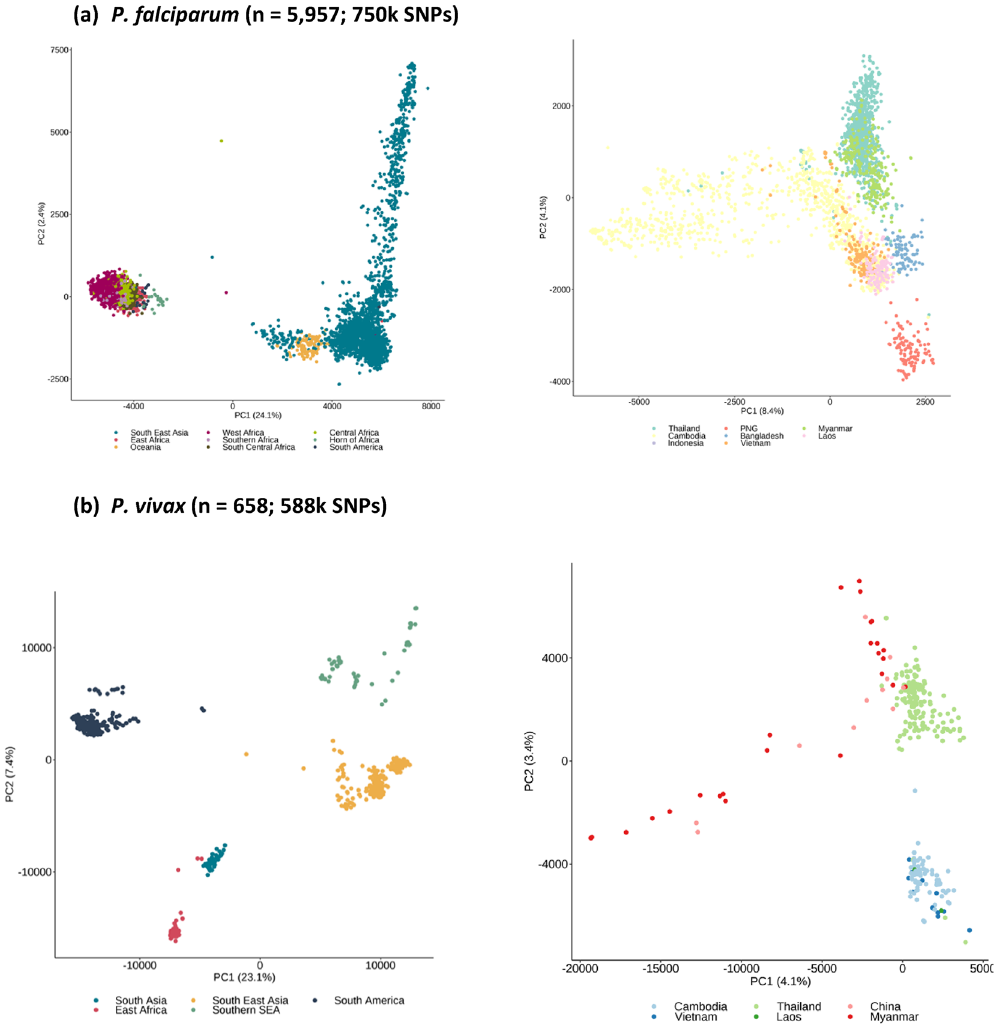
Figure 1. Population structure using principal component analysis based on all high-quality SNPs. Axes show percentage of variation explained by each principal component